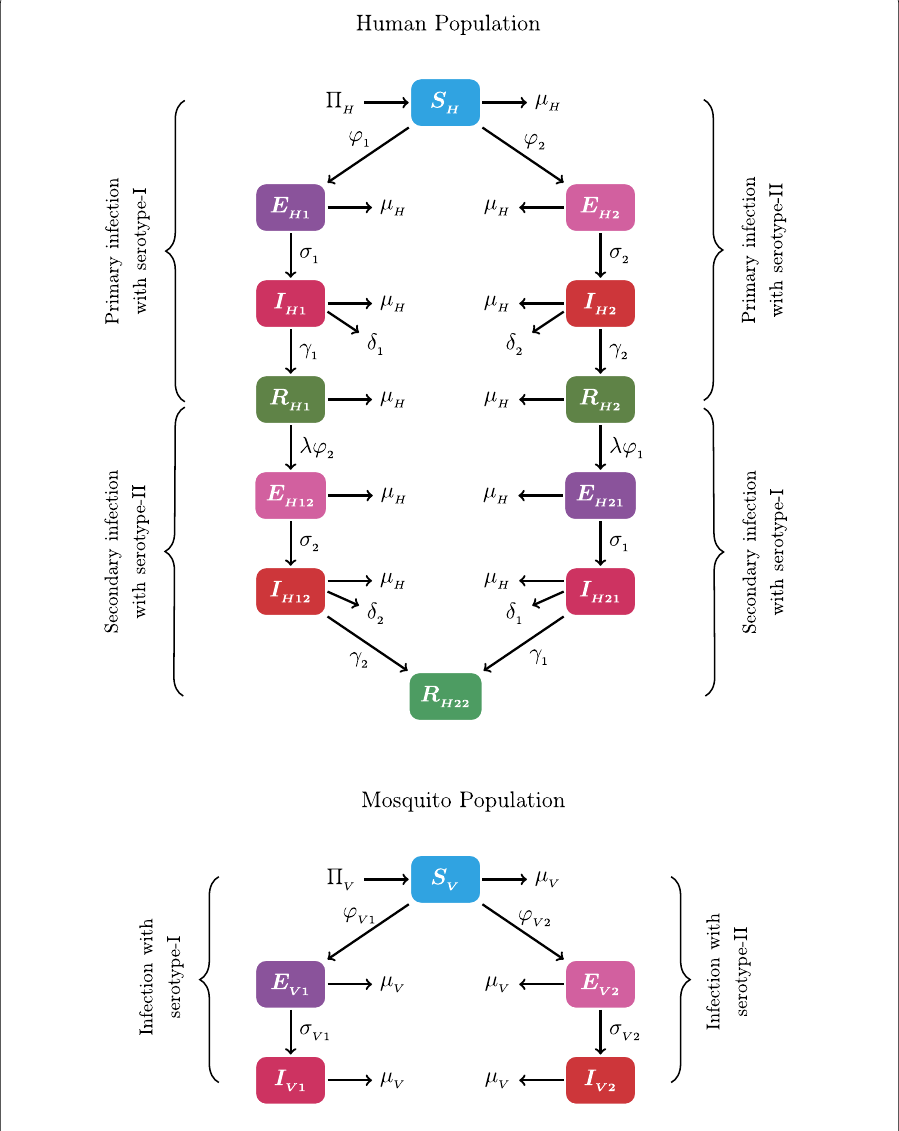
Figure 1 Schematic diagram of multi-serotype dengue model